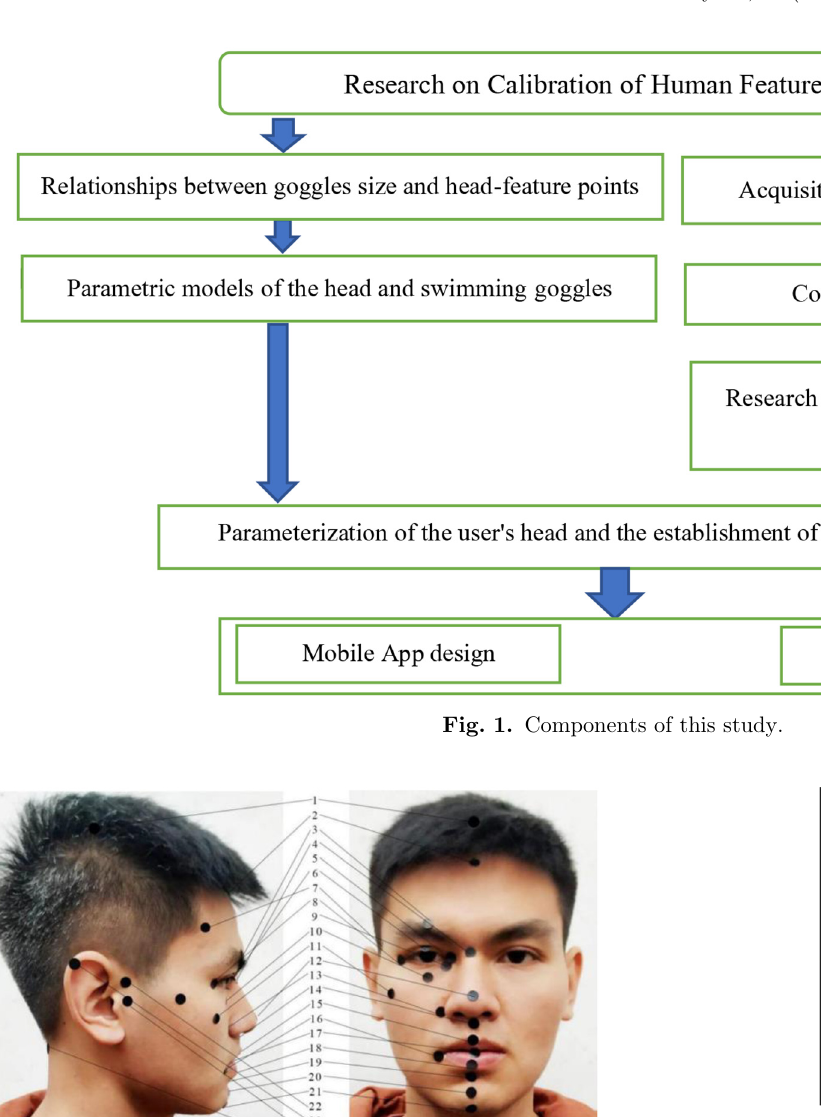
Fig. 3. Human skull